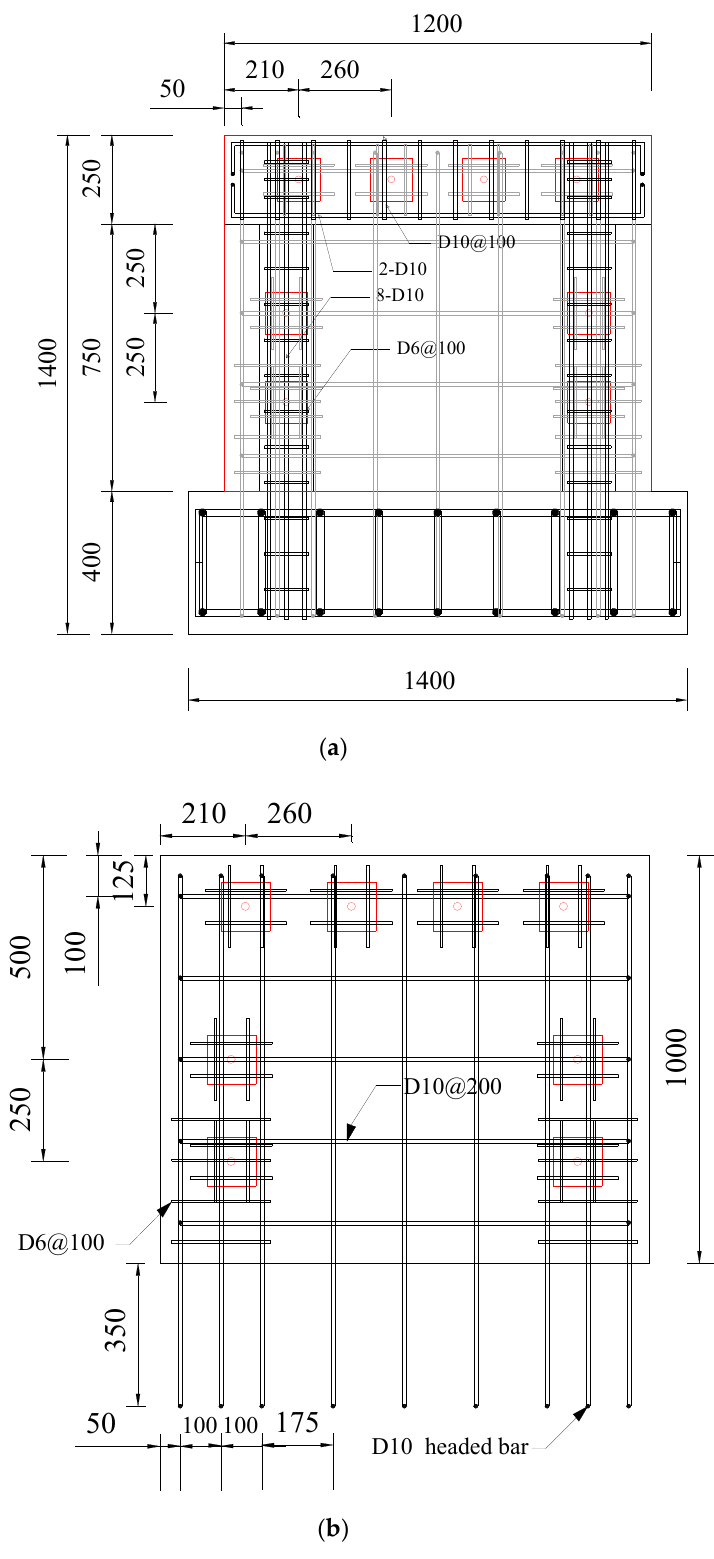
Figure 3. Details of Specimen FBC (unit: mm): ( a ) reinforcement details of frame; ( b ) reinforcement details of wall.